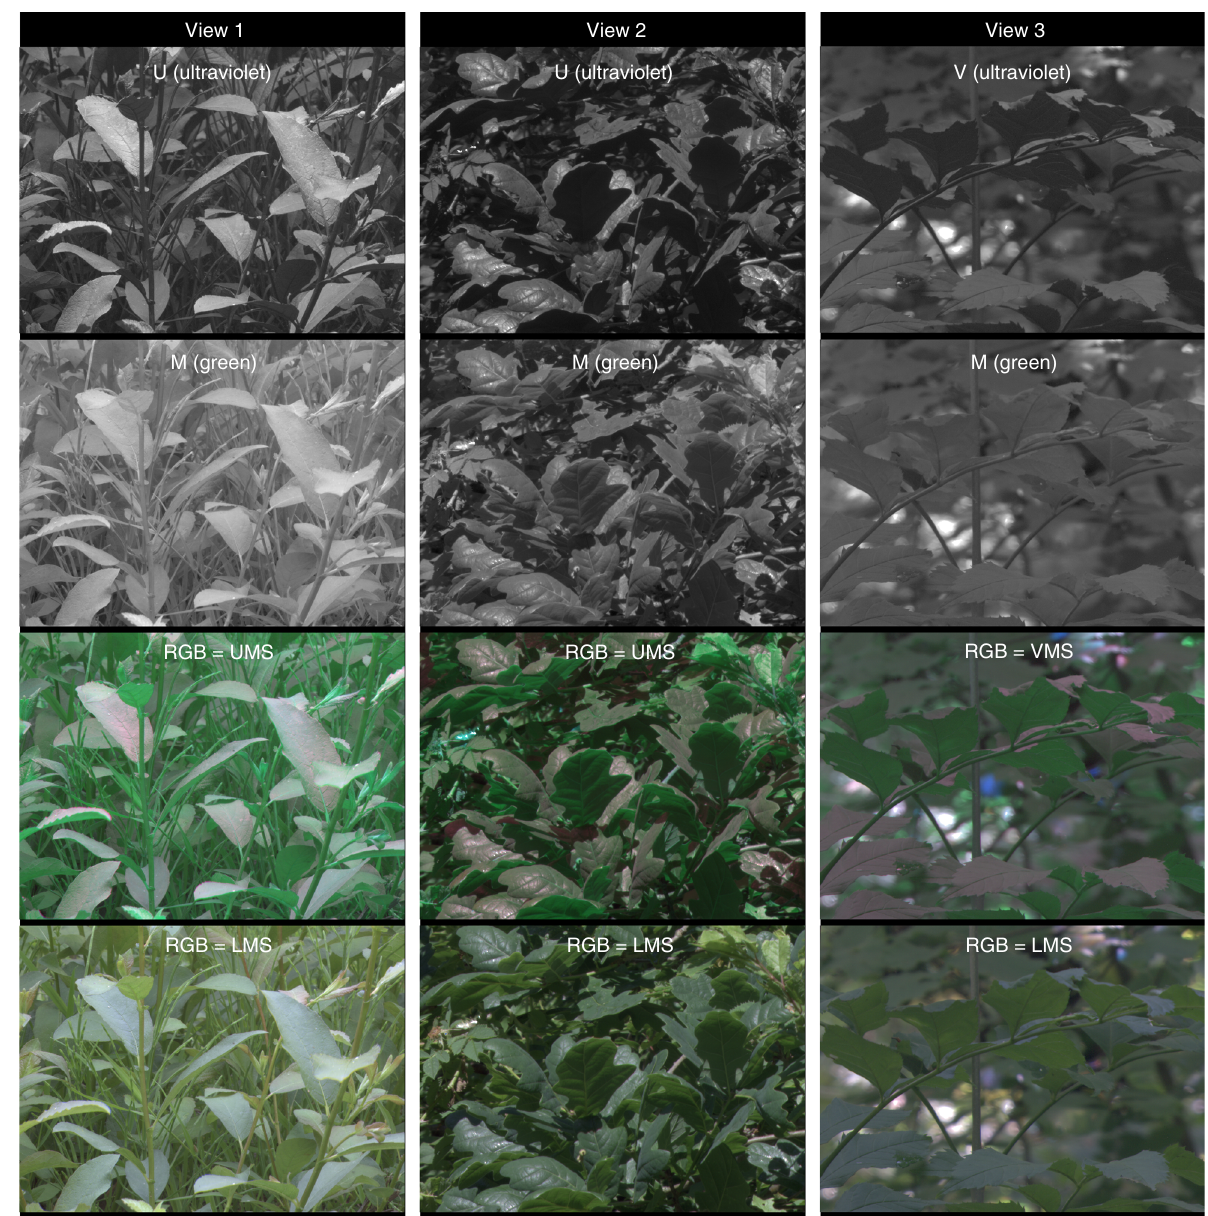
Fig. 2 Example images showing the difference in leaf-contrast seen by the UV- and green-cones in deciduous habitats in southern Sweden. For each of the three views, the top two images show the same scene as viewed by the UV and green photoreceptor channels. The UV-cone variant that saw the higher contrast is the one that is displayed. The bottom two images are false-color RGB images with three of the four avian cone channels plugged into the R (red), G (green), and B (blue) channels of a digital display. For example, RGB = UMS denotes that the U-cone is displayed by the red channel of an RGB display, the M-cone by the green channel, and the S-cone by the blue channel. Note that the upper row of RGB images contains a UV channel and the lower row does not. For display purposes, pixel values from original captured images have been (1) normalized by the mean pixel value in each image, (2) adjusted to fi ll the dynamic range of an sRGB digital display, and (3) adjusted to undo the sRGB gamma scaling of most digital display devices. This means that, viewed on an sRGB-calibrated display, within each channel, pixel intensity scales linearly with cone output. If a pixel was overexposed or underexposed in any channel, the corresponding pixel in all channels was set to white (for overexposed) or black (for underexposed), and excluded from all calculations. Note that false-color images cannot replicate what animals actually see, but provide the best approximation